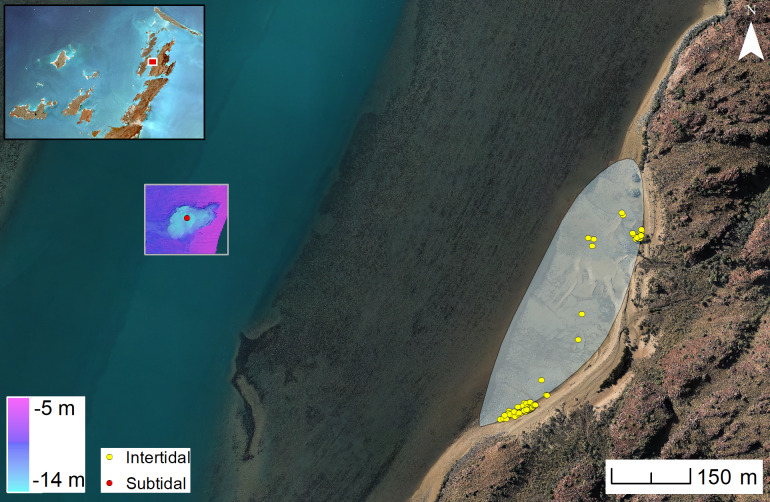
Flying Foam Passage where multibeam sonar imaging of the submerged spring shows the location where a lithic artefact was discovered at −14m (MSL).Distance from the findspot to the Dolphin Island intertidal site is approximately 600 m. Maps used are © Commonwealth of Australia (Geoscience Australia), satellite image by Sentinel (in the public domain).